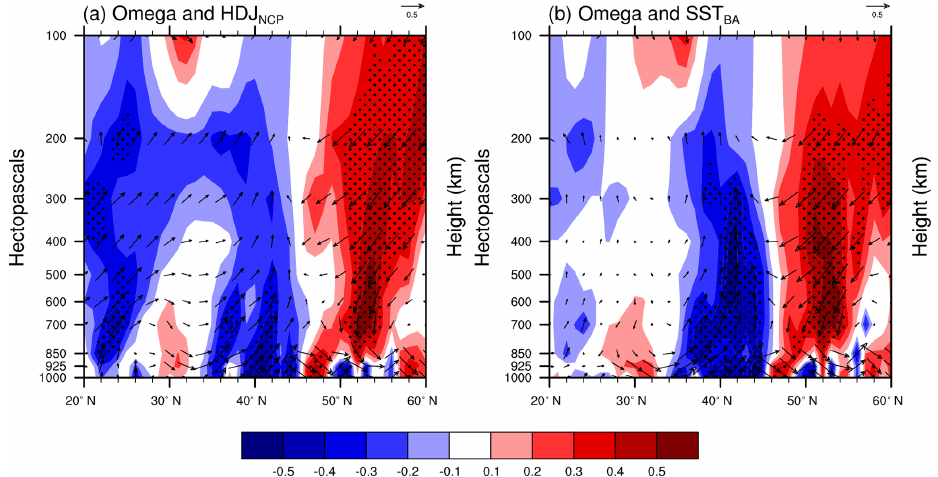
Figure 15. The cross section (114–120 ◦ E mean) CC of (a) the HDJ NCP and (b) November SST BA for omega (shading) and wind (arrow) in December–January from 1979 to 2015. The black dots indicate that the CCs exceeded the 95% confidence level ( t test). The linear trend was